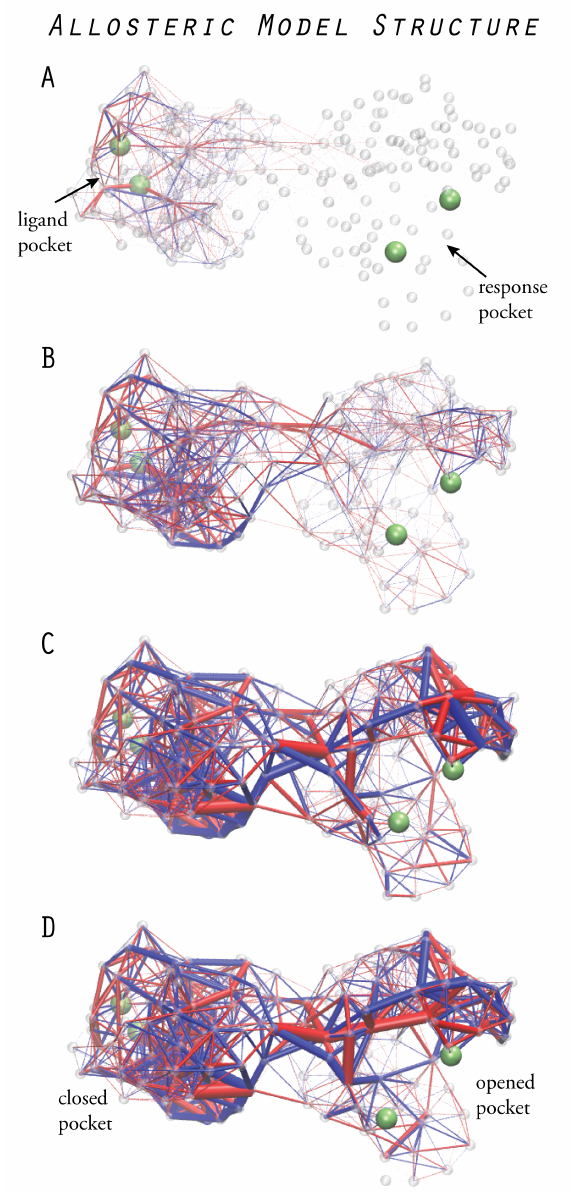
Figure 5. Designed allosteric structure. Prototype elastic network structure with an asymmetric allosteric response. The propagation of strain, shown at different moments of time after ligand binding ( A – D ), reveals communication pathways which couple the dynamics of the remote pockets (snapshots adopted from Reference